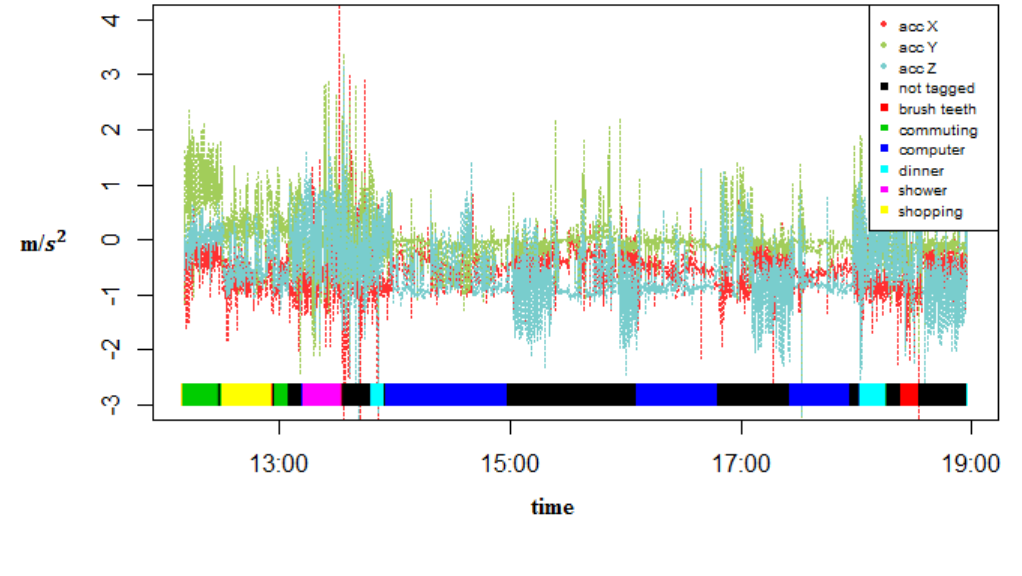
Figure 3. Raw accelerometer data and tagged activities during one specific day.